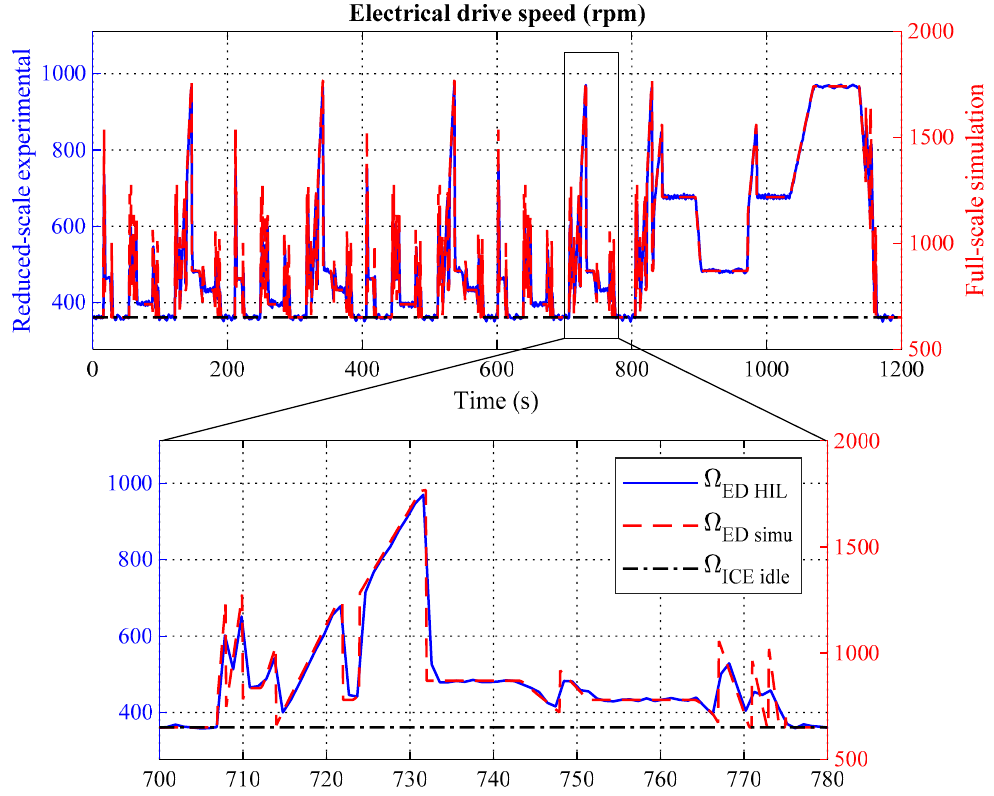
Figure 12. (Experimental) electrical drive speed (also emulated ICE speed) with NEDC.